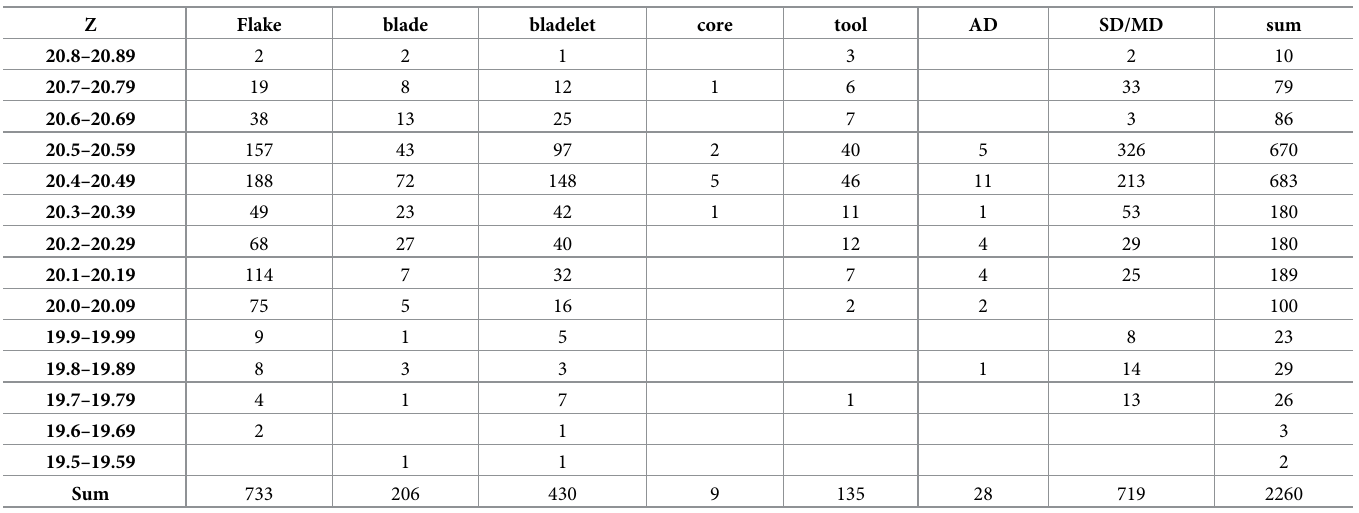
Table 3. All lithic artifacts from the west trench.